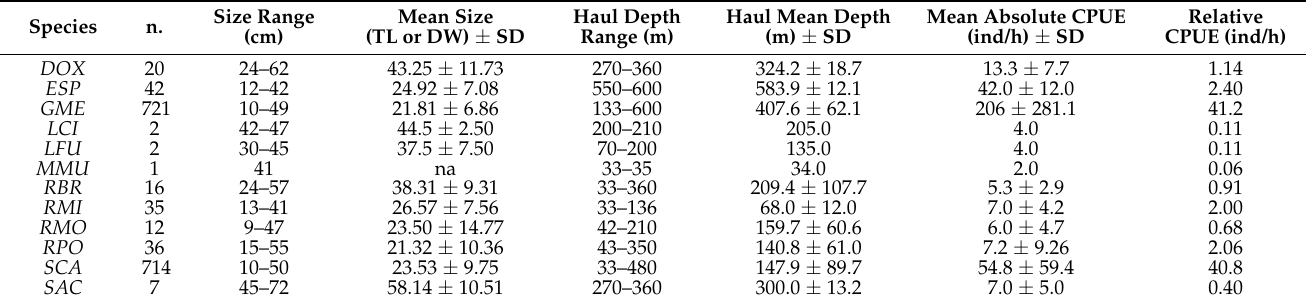
Table 3. Sample size (n.) , size range, and mean size as total length (TL in sharks) and disk width (DW in skates), haul depth range and haul mean depth (weighed on the number of individuals by haul), and mean catch per unit effort (CPUE) (as the number of individuals caught per fishing hour) by twelve species of elasmobranchs arranged in alphabetical order and sampled through a fishery- independent trawl survey in the Asinara Gulf during June–October 2022. Means are provided with their standard deviation (SD.) Species codes DOX , ESP , GME , LCI , LFU , MMU , RBR , RMI , RMO , RPO , SAC , and SCA refer to Dipturus oxyrinchus , Etmopterus spinax , Galeus melastomus , Leucoraja circularis , L. fullonica , Mustelus mustelus , Raja brachyura , R. miraletus , R. montagui , R. polystigma , Scyliorhinus canicula, and Squalus acanthias ,